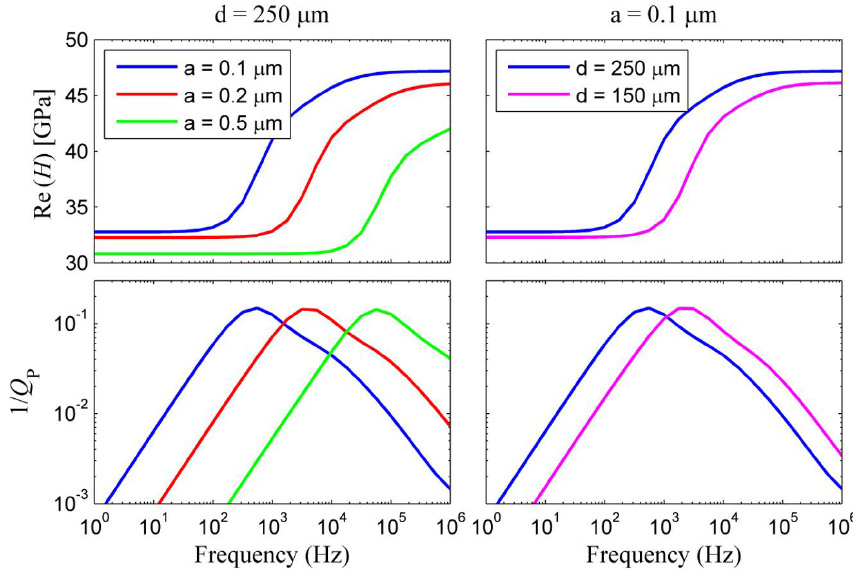
Figure 9. Real part of P wave modulus, H , and corresponding P wave attenuation, 1 /Q P , as functions of frequency for the model shown in Fig. 7, considering the grain diameter ( d ) and thickness ( a ) of the interfacial water film, which are indicated in the legends and plot